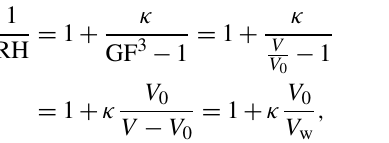
Figure 3. In situ DRIFTS spectra of populous deltoides pollen as a function of RH ( < 1%, 26%, 41%, 57%, 71%, 81% and 87%) at 25 ◦ C.